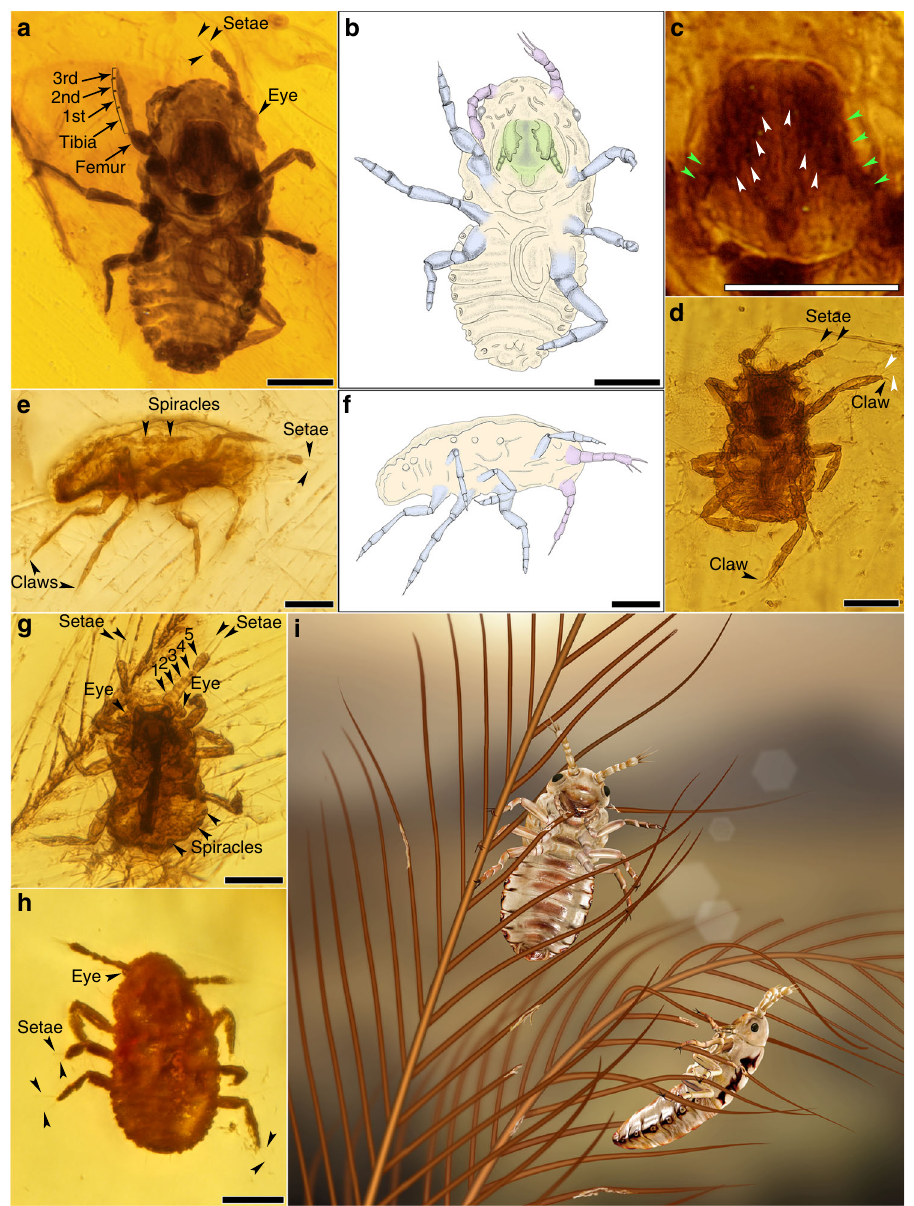
Fig. 2 Holotype and paratypes of Mesophthirus engeli Gao, Shih, Rasnitsyn & Ren, gen. et sp. nov. within the AMBER No. 01 from mid-Cretaceous. a , b Holotype and line drawing of M. engeli sp. nov., CNU-MA2016009. c Enlargement of mouthpart of a shows details of mandible and maxillary palpi, arrows in white show teeth and arrows in green show the segments of palpi. d Paratype of M. engeli sp. nov., CNU-MA2016005, shows setae on the apex of antenna and single pretarsal claw. e , f Paratype and line drawing of M. engeli sp. nov., CNU-MA2016003, show spiracles on meso- and metanotum. g Paratype of M. engeli sp. nov., CNU-MA2016001, shows details of antennae, eyes, and spiracles on the side of abdominal segments, indicating the